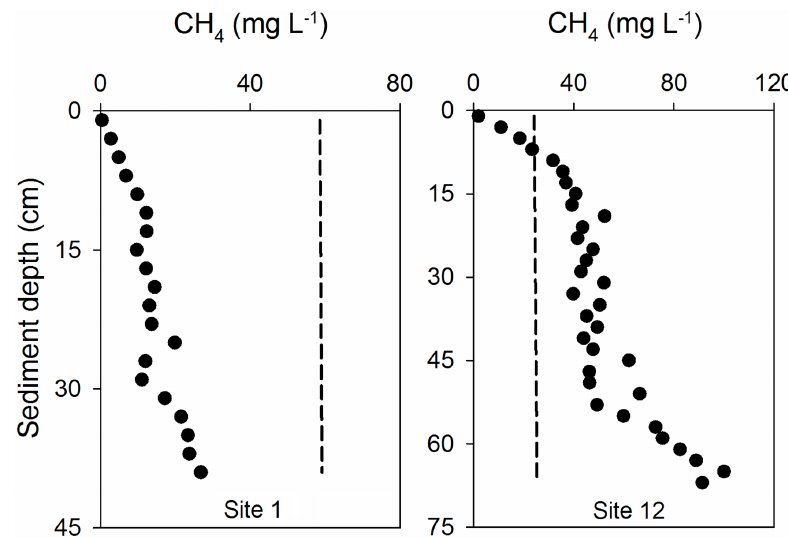
Figure B1. Example of CH 4 profiles from two coring sites showing the absence (site 1) and the presence (site 12) of CH 4 supersatura- tion in the sediment pore water. The dots represent measurements of CH 4 concentration in pore water and the dashed lines represent the calculated CH 4 saturation concentration. Saturation concentra- tion (i.e., the maximum concentration that dissolves in water, above which bubbles are formed) was calculated based on pressure and temperature along the sediment